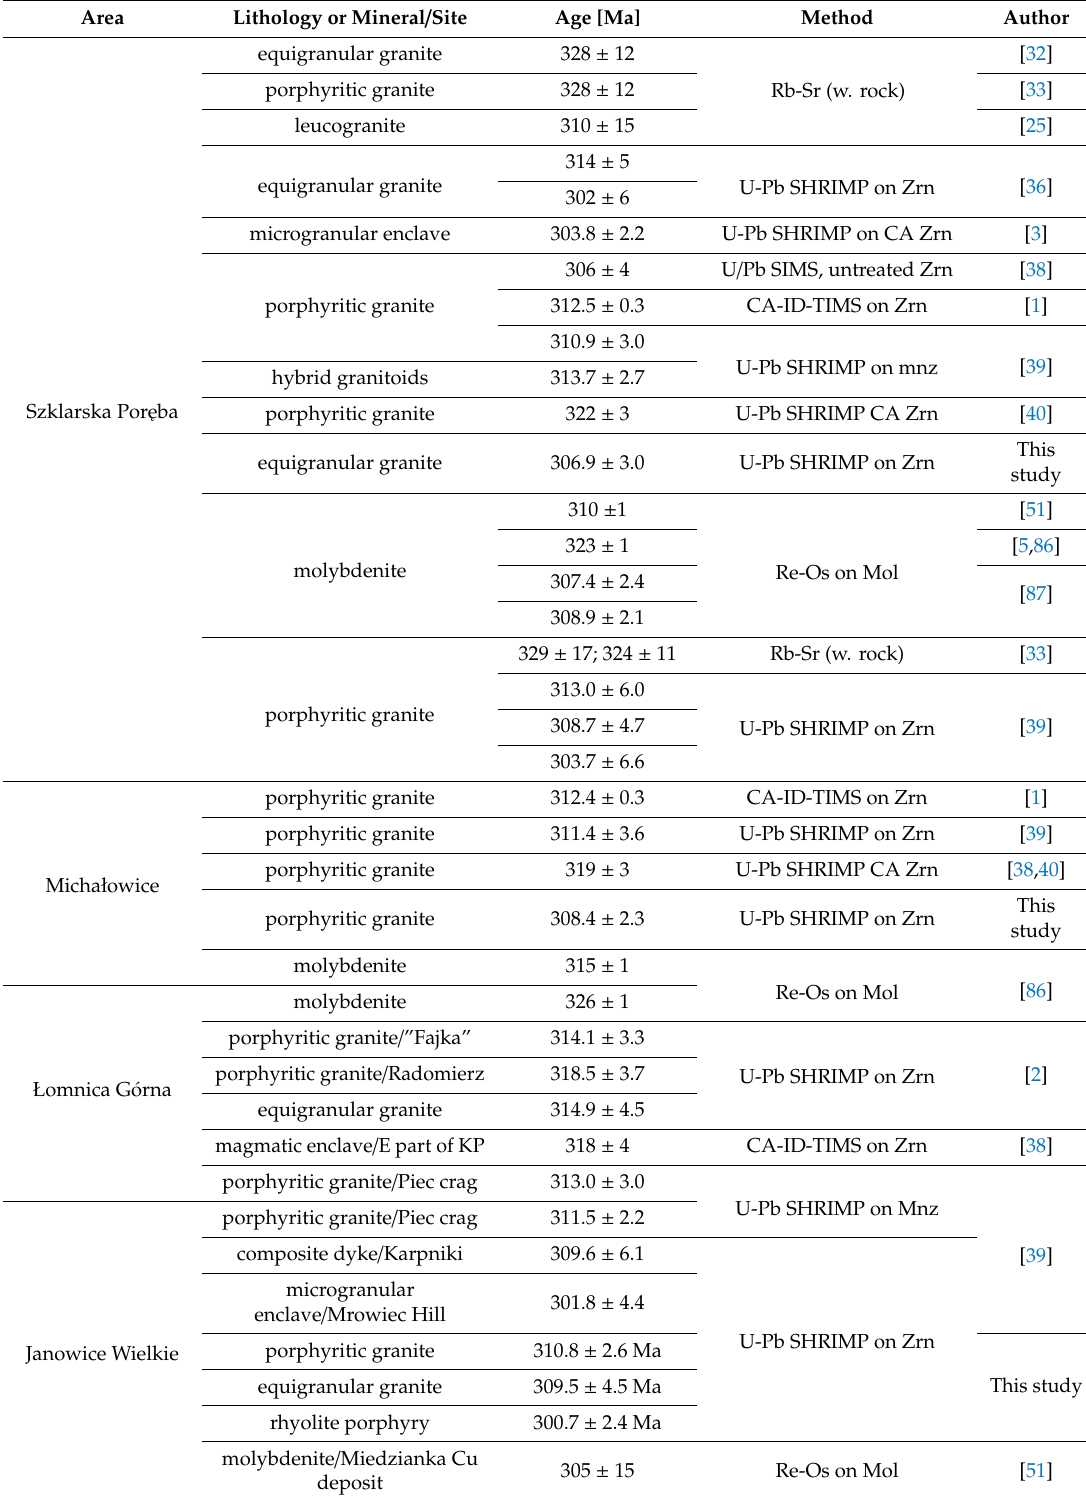
Table A1. Summary of igneous rock and sulfide dating from the Karkonosze Pluton and its Eastern Metamorphic